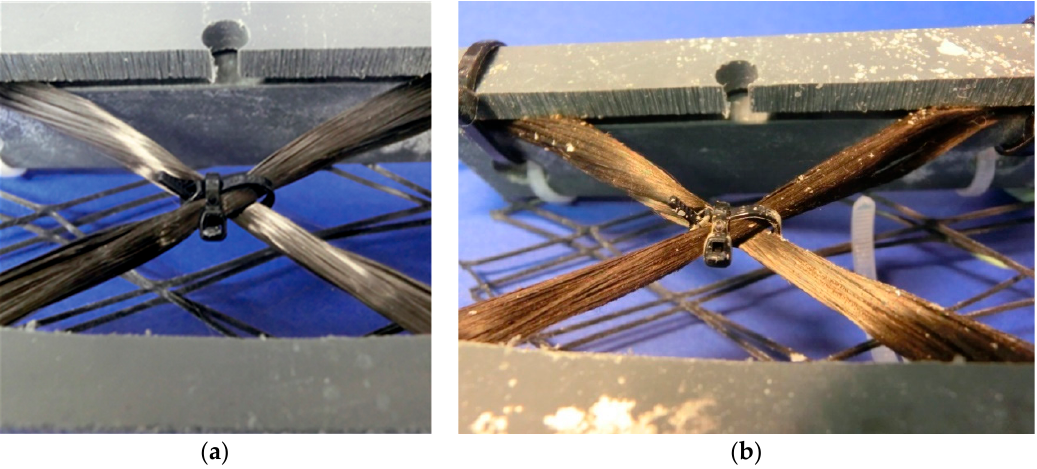
Figure 4. Unimpregnated carbon fibres before the test ( a ) and after ( b ).